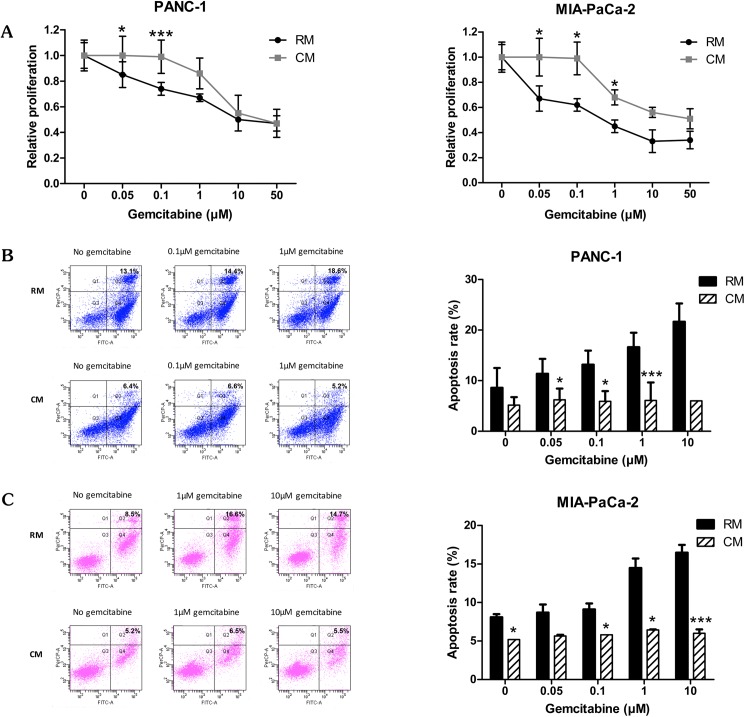
Omental fat CM augments pancreatic cancer cell chemoresistance.(A) XTT assay demonstrating a significant increase in survival of gemcitabine-treated pancreatic cancer cells following incubation with omental CM (P< .05), n = 4; (B and C) Annexin-V/PI FACS analysis demonstrating a marked reduction in gemcitabine-induced apoptosis of PANC-1 (B; P< .05) and MIA-PaCa-2 cells (C; P< .05) pretreated with omental fat CM, n = 5.